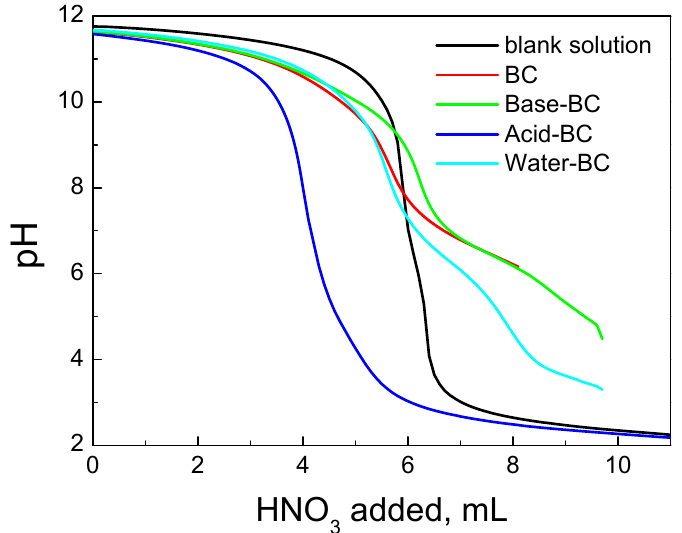
Figure 2. Potentiometric titrations of the studied biochars with the titration of the blank solution.